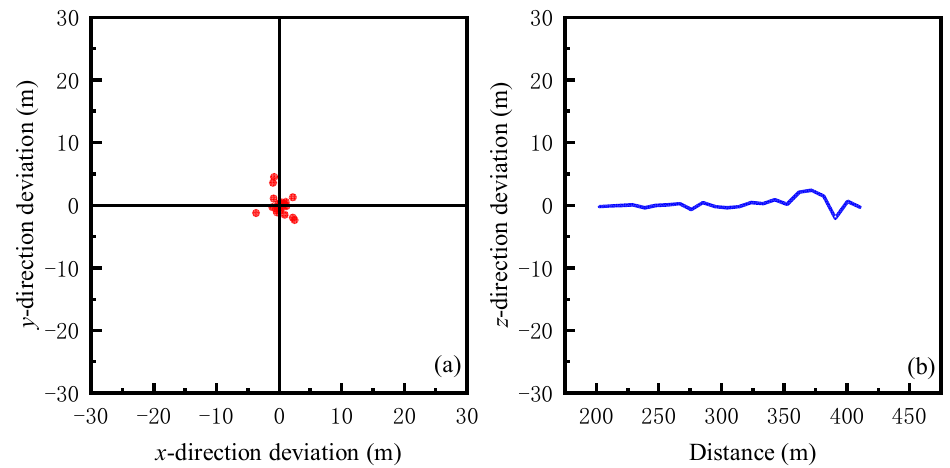
Table 6. Result of independent 2-sample t -test.